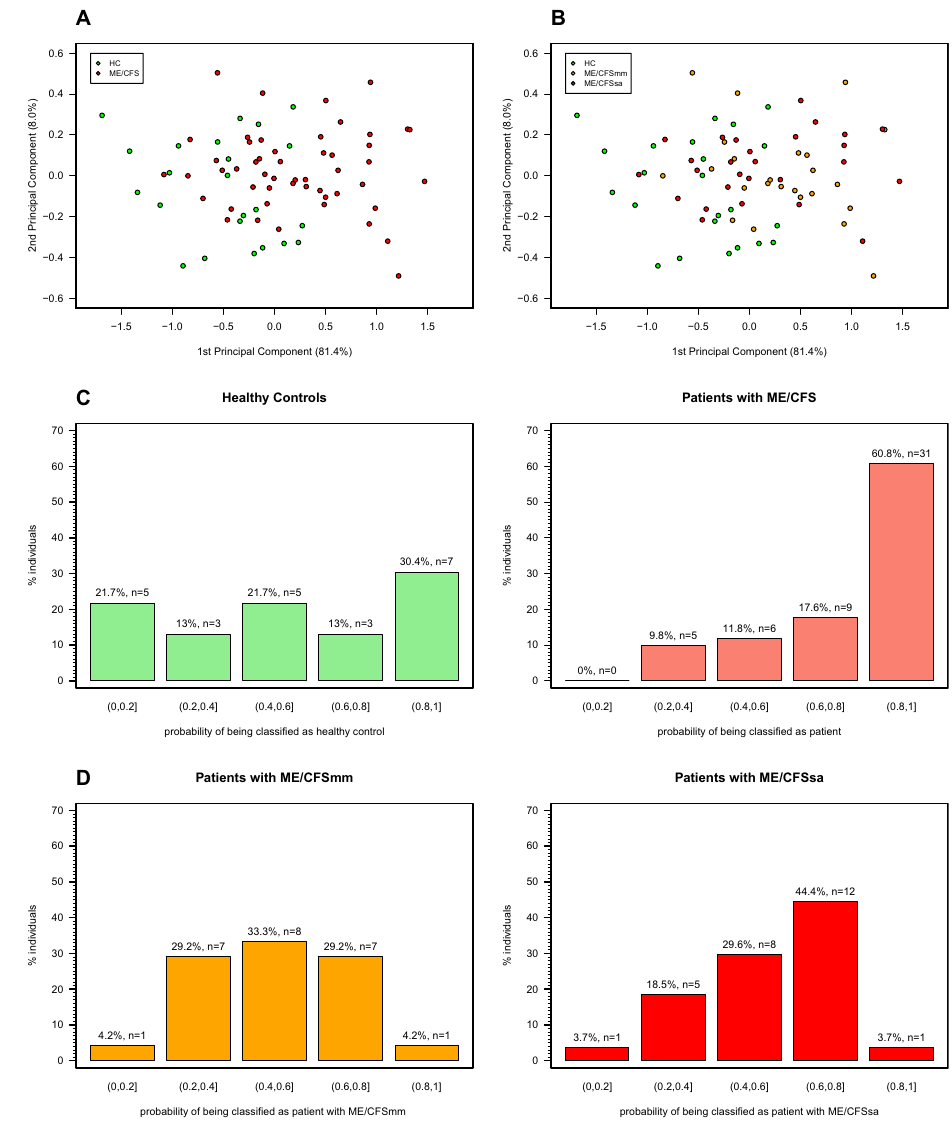
Figure 3. Principal component analysis and linear discriminant analysis derived from miR expression data in plasma. The scatterplots show the representation of each study participant in the first two principal components. The scatterplots ( A ) and ( B ) are the same but color-coded according to healthy controls (HC) versus patients with ME/CFS and according to healthy controls, mild/moderate (mm) and severely affected (sa) ME/CFS patients, respectively. The barplots ( C ) represent the frequency of HC and patients with ME/CFS and their corresponding classification probability of being classified as such according to a linear discriminant analysis distinguishing patients from controls specifically. The barplots ( D ) are similar to ones shown in ( C ), but for a linear discriminant analysis distinguishing mild/moderate patients from severely affected patients specifically. The statistical analysis was performed in the R software version 4.0.2 (https:// www.r- proje ct.